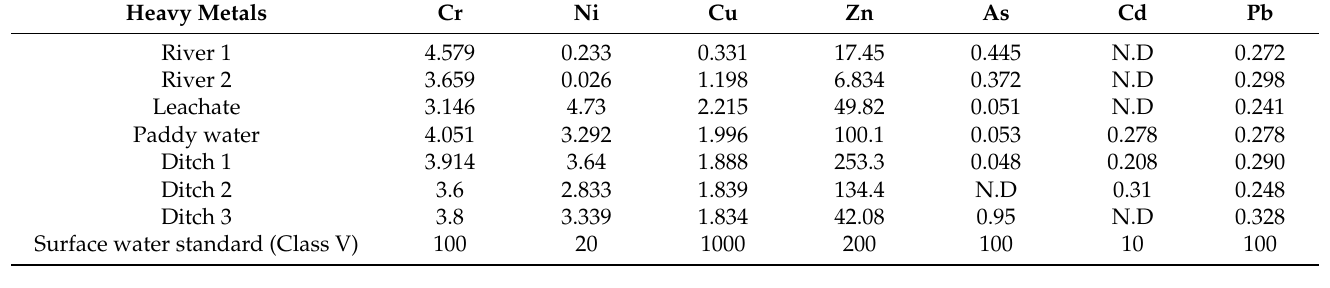
Figure 2. Physical and chemical properties of soil samples. ( a ) Organic matter content of sampling points. ( b ) pH of sampling points. (sampling points: (1, 3, 5, 6) pak choi, (2) rice; (4) spring onion; (7, 10) radish; (8) Chinese cabbage; (9) Chrysanthemum coronarium ).